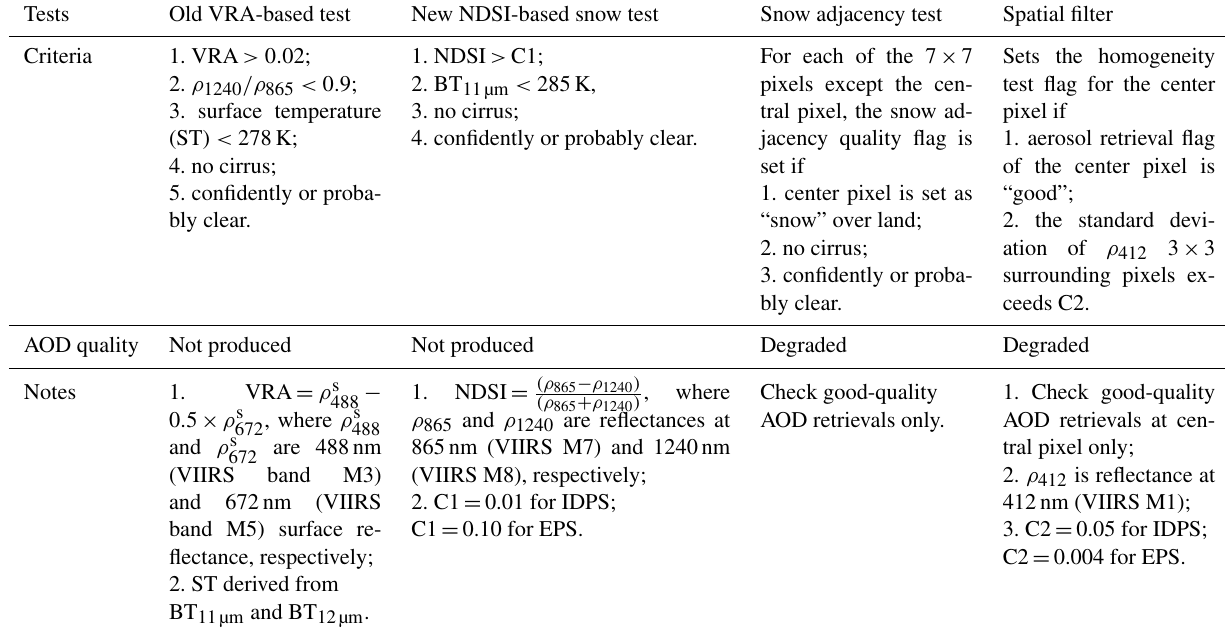
Table 1. Criteria for the VRA-based snow test, the NDSI-based snow test, the snow adjacency test and the homogeneity